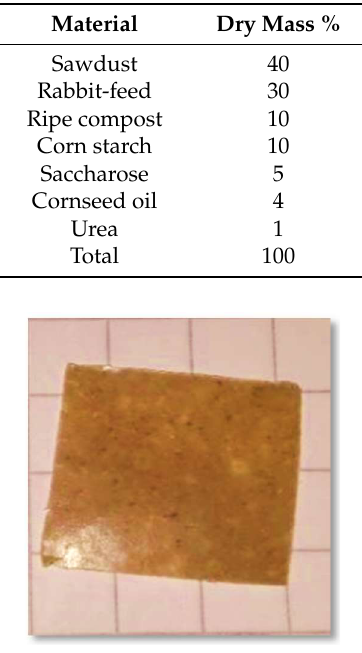
Figure 8. Sample used for the disintegration test.